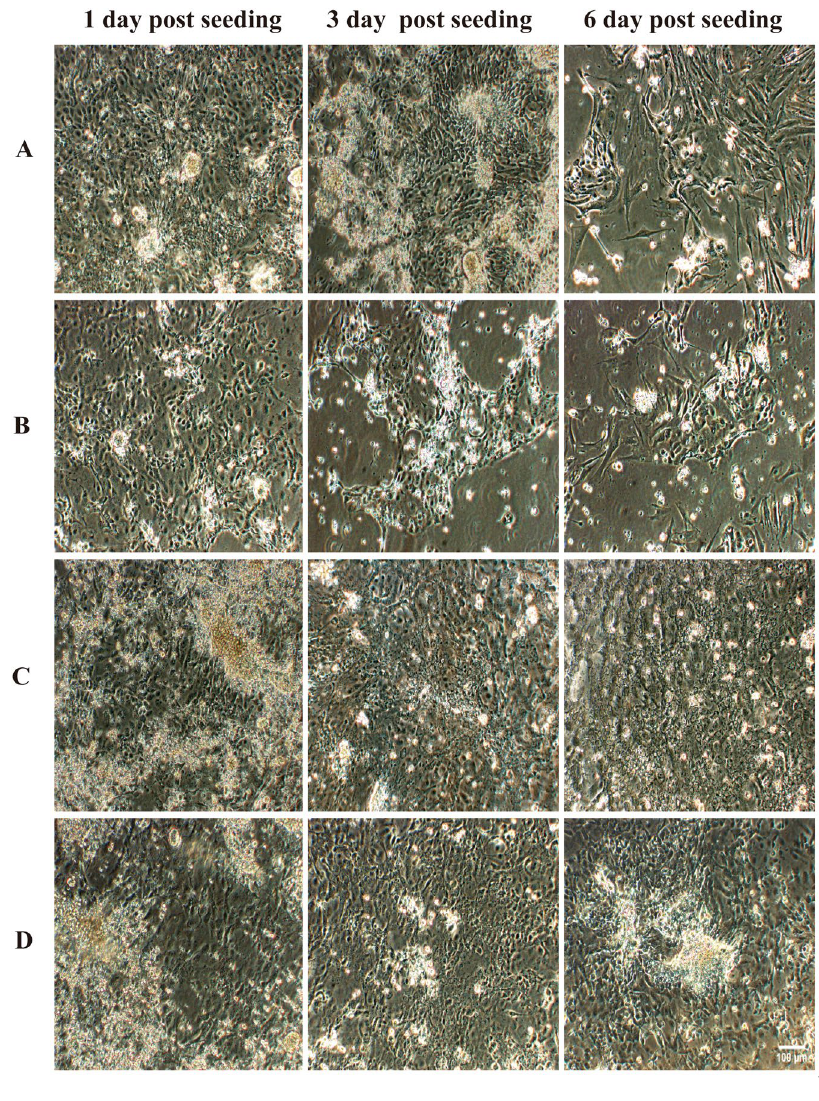
Figure 3. Evaluation of different methods to support the growth of primary porcine ileum and colon epithelial cells. ( A ) Porcine ileum epithelial cells were cultured without myofibroblasts on a porcine collagen type I/III coated plate. They could live approximately 2 days before detaching and dying, fibroblasts took over 6 days after seeding. ( B ) Porcine ileum epithelial cells were cultured without myofibroblasts on a porcine collagen type I/III coated plate with medium supplemented with 20% conditioned medium collected from ileum myofibroblasts. Epithelial cells could be maintained for less than 3 days and a few tiny epithelial clusters were present at 6 days post seeding. Porcine ileum ( C ) and colon ( D ) epithelial cells were cultured in the presence of ileum myofibroblasts. Epithelial cells grew into a monolayer 3 days post co-cultivation and maintained their morphology for more than 6